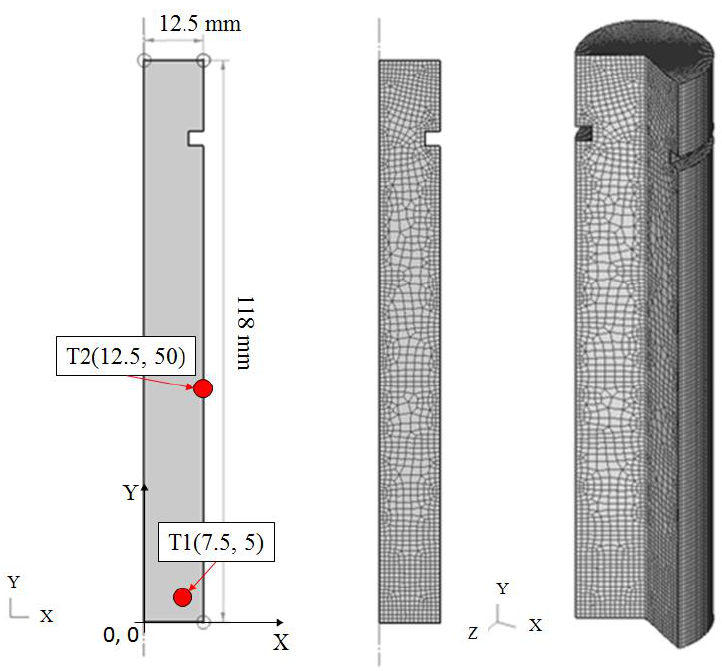
Figure 4. Geometry of Jominy end quench test sample and transfer to FEM (2D and 3D